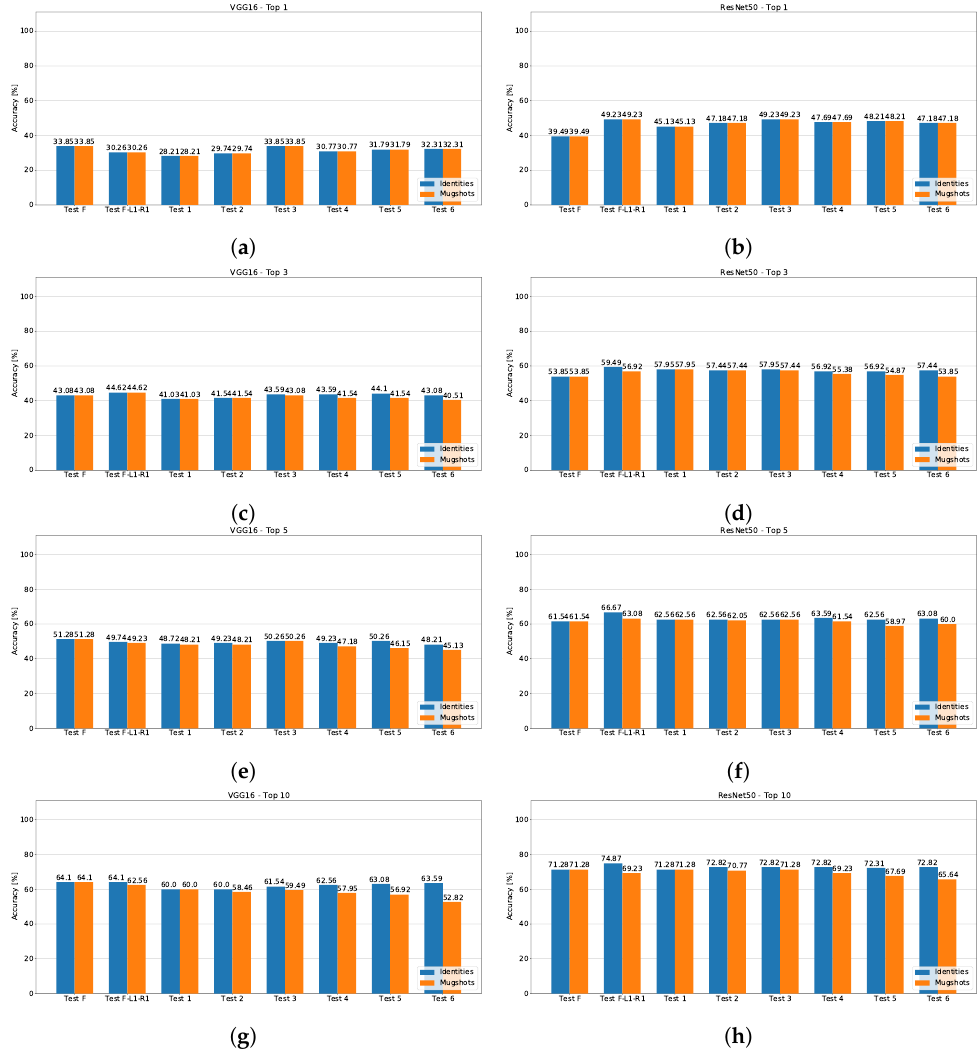
Figure 7. Accuracy measures for ResNet50 (right) and VGG16 (left) on the proposed database. The charts include the top-1 ( a , b ), top-3 ( c , d ), top-5 ( e , f ), and top-10 ( g , h ) rankings in terms of nearest identities (blue) and mugshots